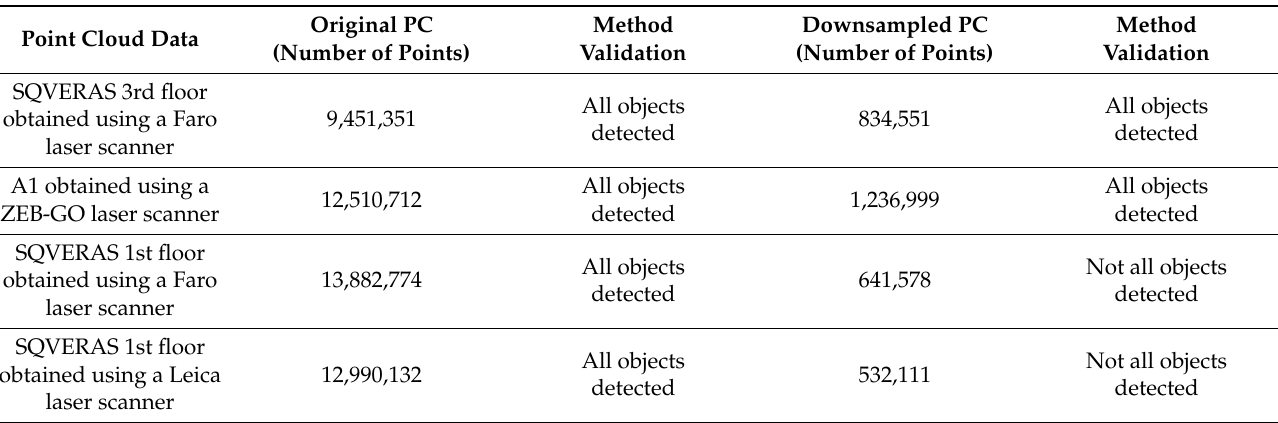
Figure 15. Example of downsampling: ( a ) original point cloud, and ( b ) downsampled point cloud. Table 4. Object detection results considering data reduction.